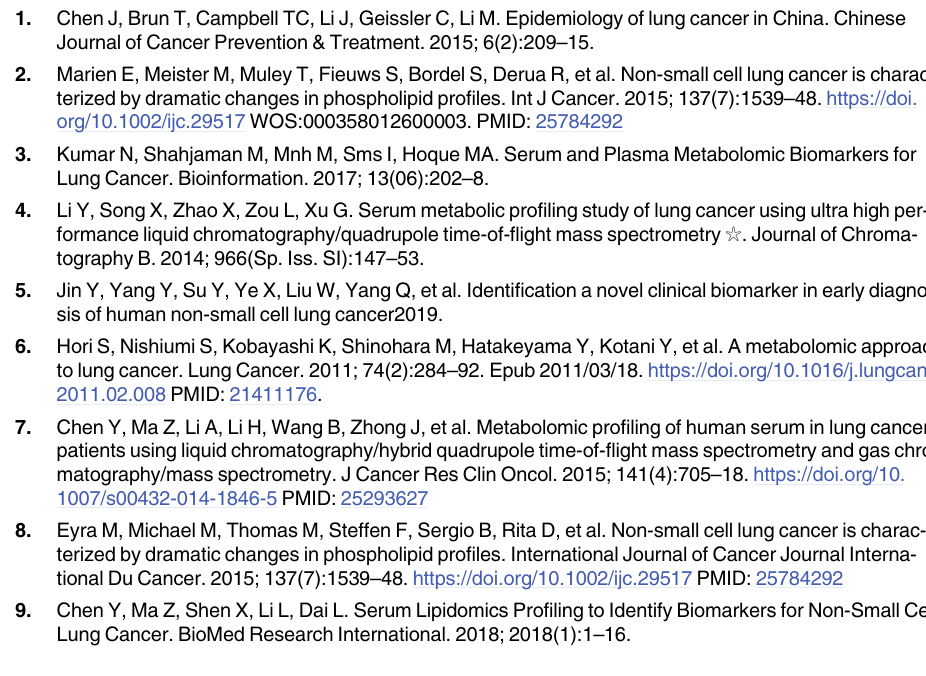
S6 Table. R2X, R2Y and Q2 of multivariable analysis in ESI+ or ESI- mode by PCA-X or